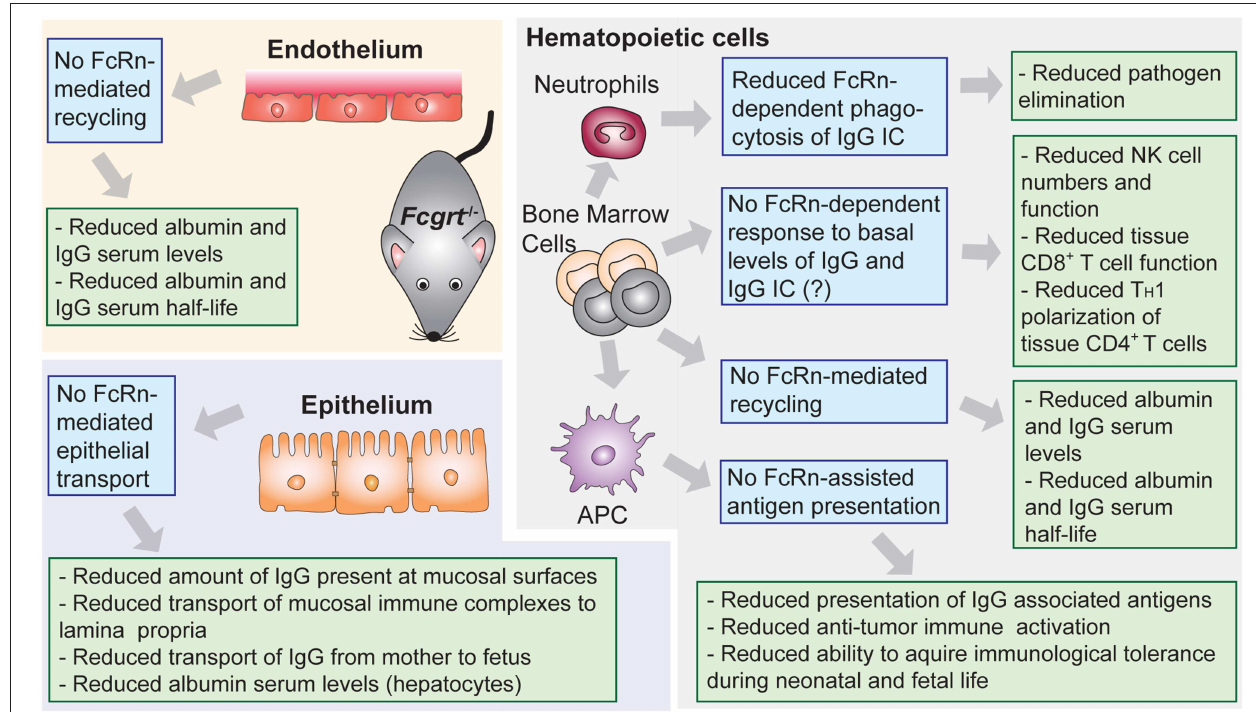
FIGURE 2 | Lessons from conventional and conditional FcRn deficient mouse models. Phenotypic observations reported in mice deficient for FcRn (Fcgrt − / − ). Blue boxes denote FcRn-affected function and green boxes denote pathophysiological consequences.